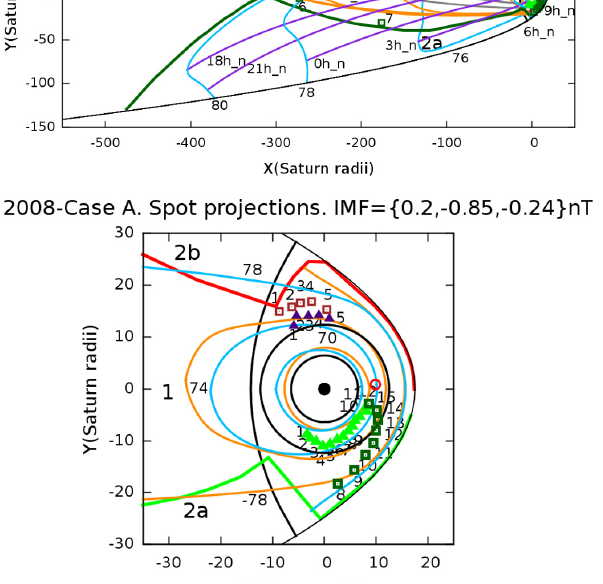
Fig. 7. As in Fig. 1 but with the boundary points of the bright auroral regions (a large dawn auroral patch, a narrow dusk arc aligned in the noon–midnight direction, and a small bright spot near noon) mapped into the equatorial plane superposed.